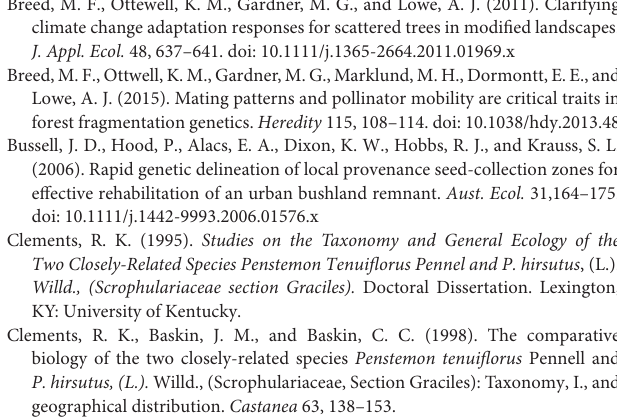
Figure S1 | The output from a LOCPRIOR model in STRUCTURE (burn-in of 10,000 with 10,000 iterations and K = 6) shows genetic differentiation between the natural prairie populations (LN, LS, and MD) and the green roof populations (CN, CS, and QN) used in this